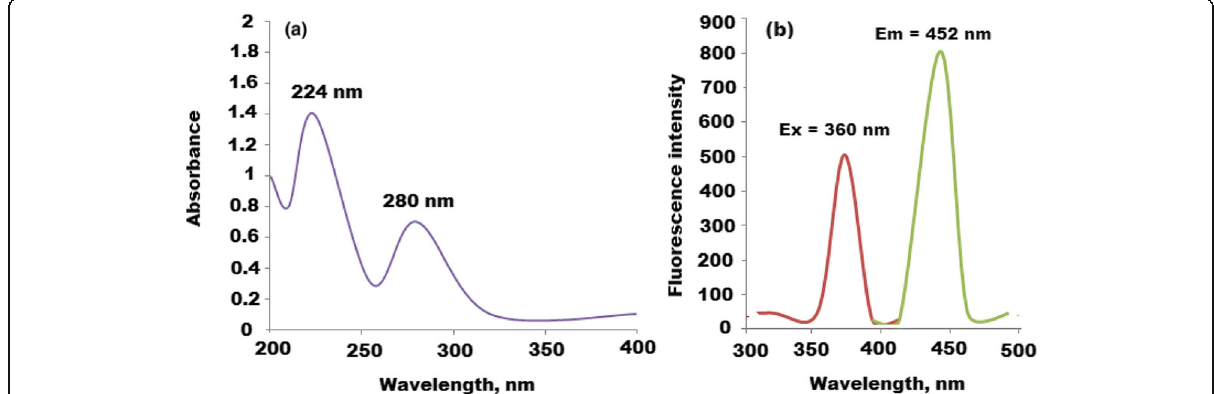
Fig. 3 Spectroscopic spectra of CQDs ( a ) UV-Vis spectrum at 224 and 280nm and ( b ) fluorescence spectrum of CQDs at λ ex =360 and λ em